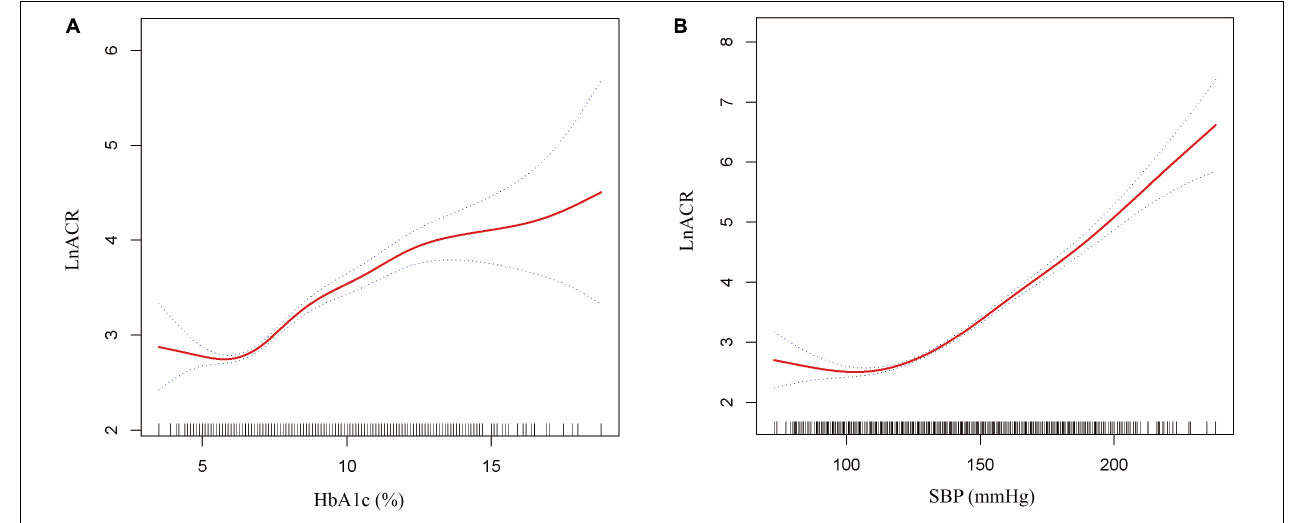
FIGURE 2 | Non-linear relationship between ACR and HbA1c or SBP. (A) lnACR with HbA1c (B) lnACR with SBP. The solid red line is the fitted curves and the dotted curves are the 95 CI of the fit. All analyses were adjusted for age, sex, marital status, education level, smoking, alcohol consumption, diabetes duration, body mass index (continuous), waist circumference (continuous), fasting plasma glucose, glycated hemoglobin/systolic blood pressure, diastolic blood pressure, triglyceride, uric acid, estimated glomerular filtration rate and dietary protein.